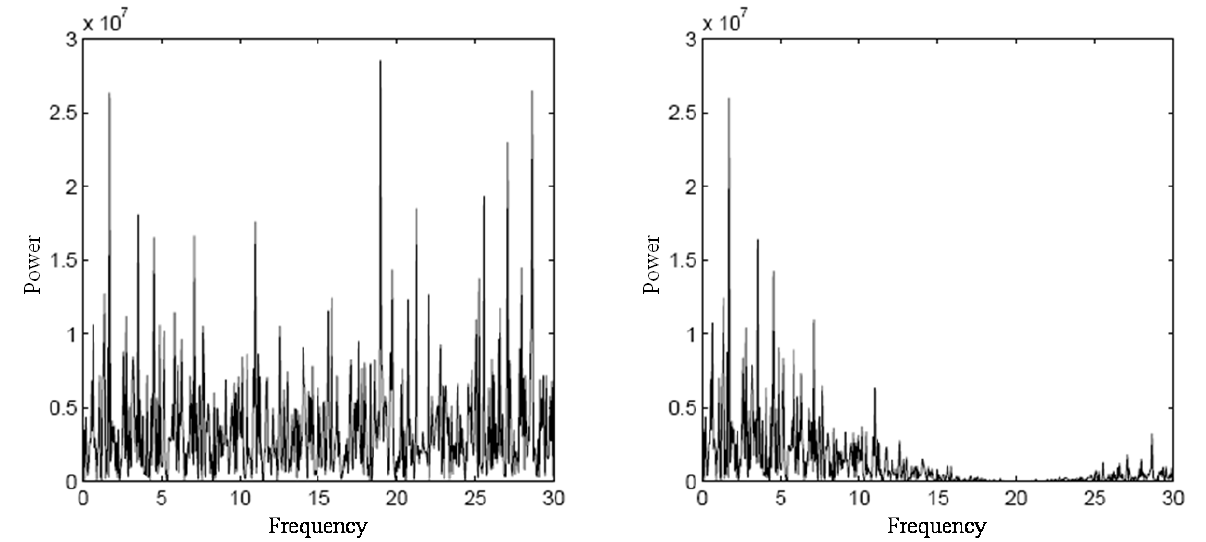
Figure 5. Spectral plots for non-averaged time-series (left) and averaged time-series (right). Unlike the monofractal analyses, data-averaging did not seem to have any effect on mutlifractal spectrum width. More importantly, the analyses of the shuffled surrogates still resulted in a significant difference in multifractal spectrum width for the real eye